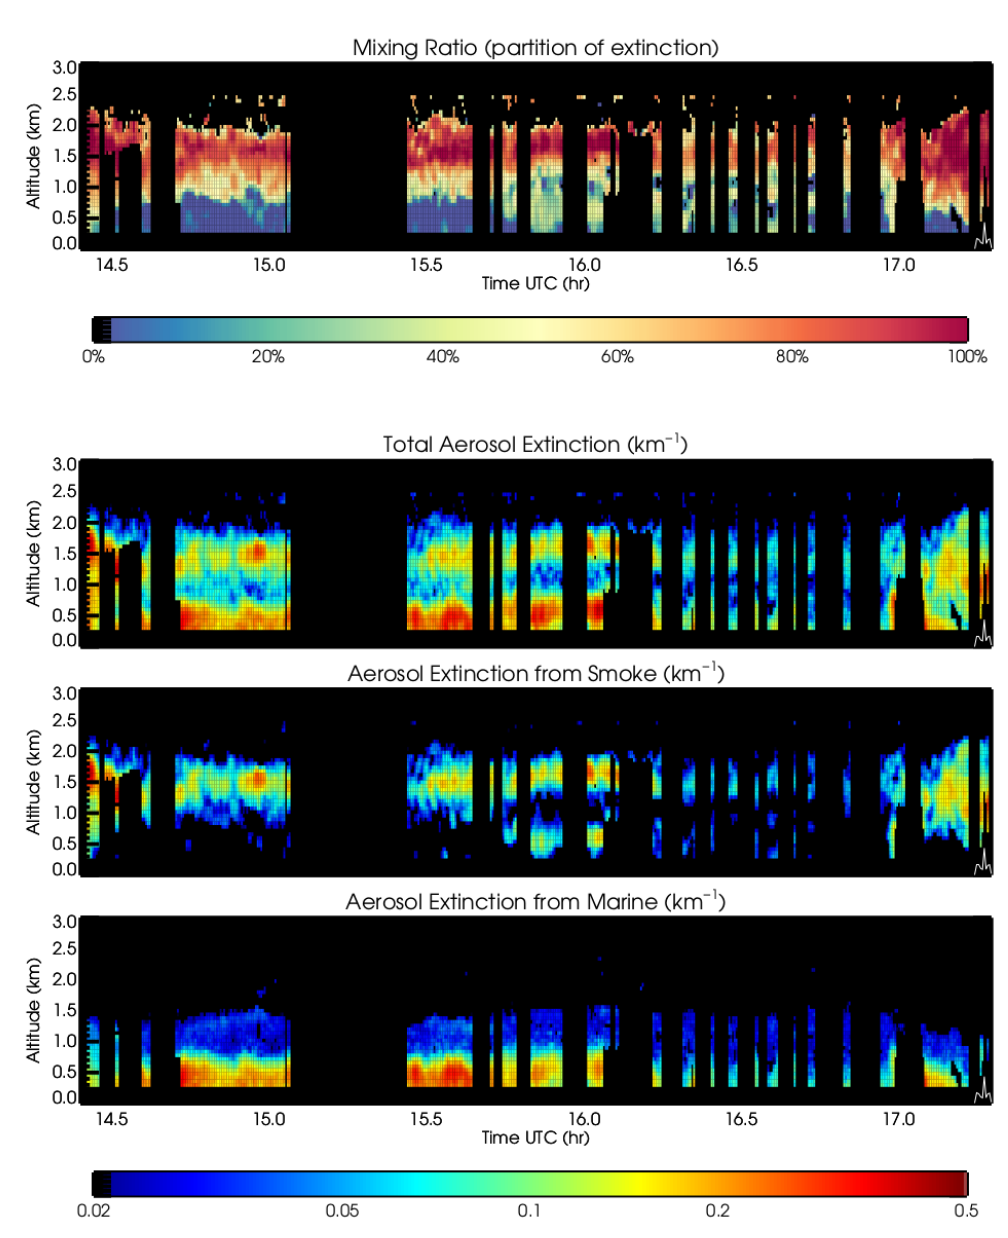
Fig. 11. Top shows extinction mixing ratio (percentage of 532nm extinction due to smoke) for the mixtures of marine and smoke aerosol observed by HSRL-1 on 28 March 2006 in the Gulf of Mexico. The extinction mixing ratio is inferred from the measurements and Eqs. (30)– (32) as described in the text. Blue indicates marine and red is smoke. Bottom three panels show the partition of aerosol extinction at 532nm into separate contributions by marine and